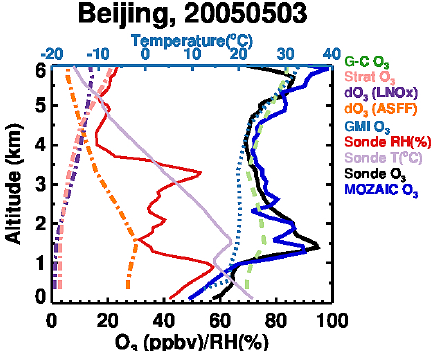
Figure 9. Vertical profiles of O 3 mixing ratios (ppbv) over Bei- jing from ozonesonde (black solid line) and MOZAIC aircraft (blue solid line) measurements on 3 May 2005 compared to those simulated by GEOS-Chem/GEOS-4 (green dashed line) and GMI/GEOS-4 (blue dotted line). Sonde-observed RH (%) and tem- perature ( ◦ C) are shown as red solid line and purple solid line, respectively. Decreases in O 3 concentrations (ppbv) when Asian fossil fuel or lightning NO x emissions were suppressed, relative to the standard simulation, are shown as orange and purple dot– dashed lines, respectively. O 3 transported down from the strato- sphere (ppbv) is shown as pink dot–dashed